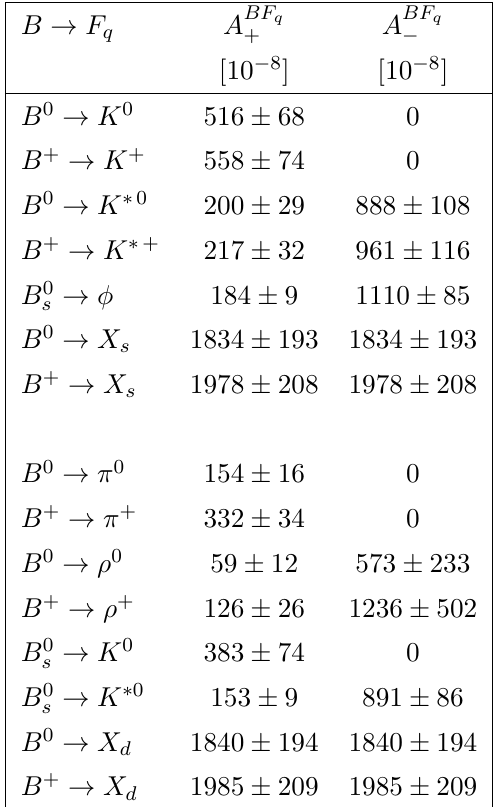
Table 1 . Coefficients A BF q